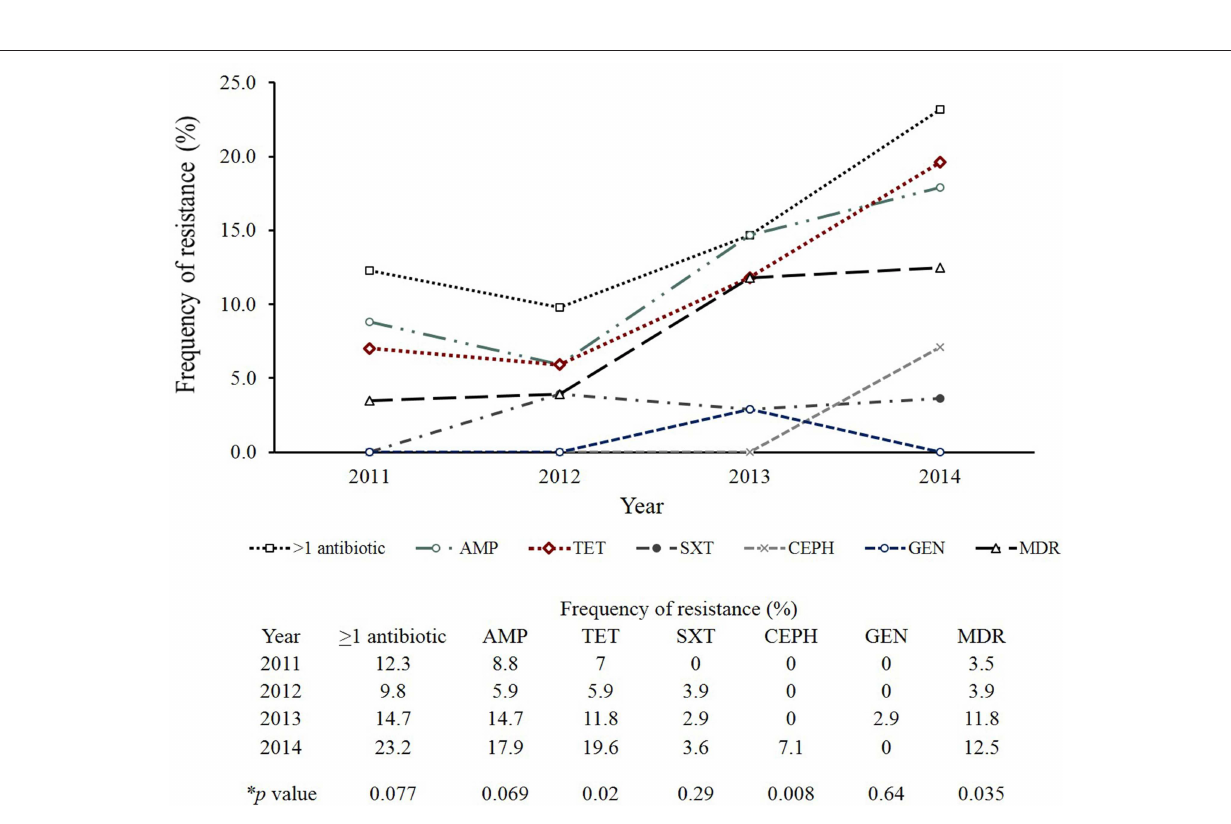
FIGURE 4 | Trends in antibiotic resistance among clinical non-typhoidal Salmonella (NTS) isolates from Michigan over time. Mantel-Haenszel chi-square was used to identify trends over time and calculate p -values. AMP, Ampicillin; TET, Tetracycline; SXT, Trimethoprim/sulfamethoxazole; CEPH, Cephalosporin; GEN, Gentamicin; MDR, Multidrug resistance (resistance to ≥ 3 antimicrobial